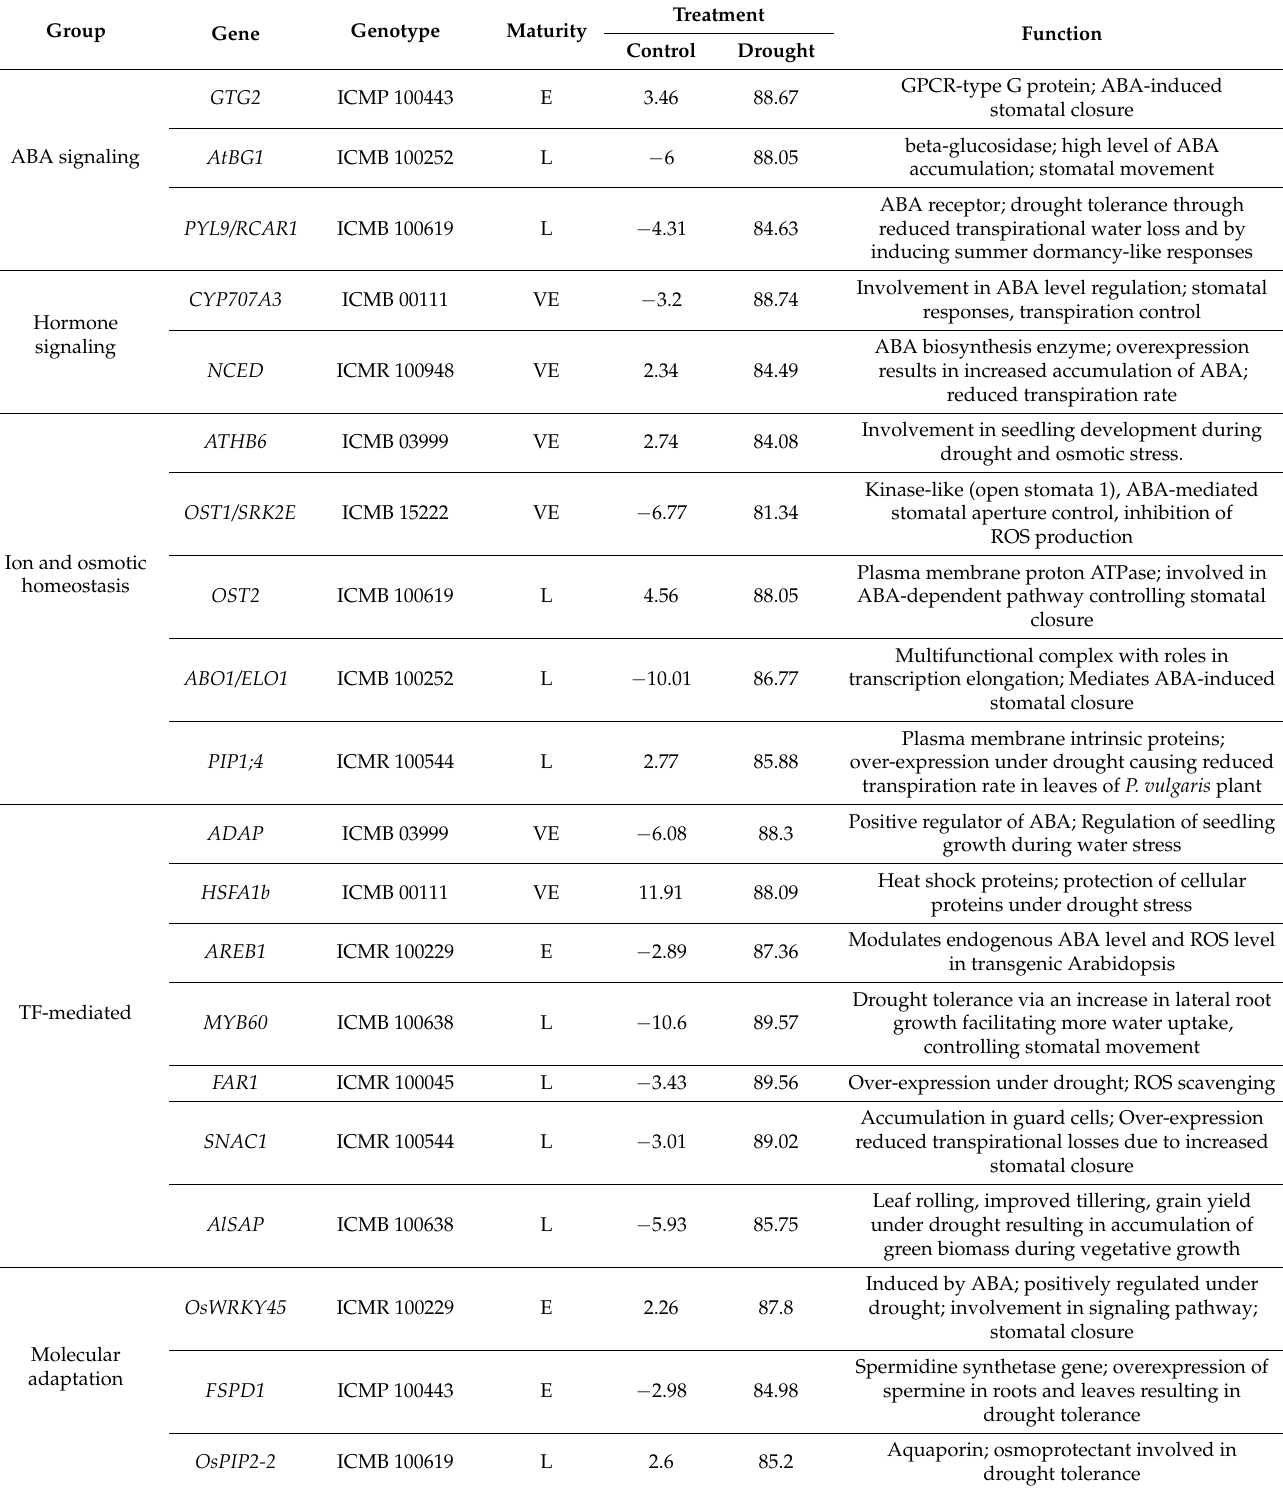
Table 1. Important drought genes and their characteristics under various functional